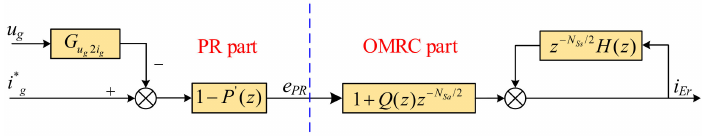
Figure 11. Block diagram of